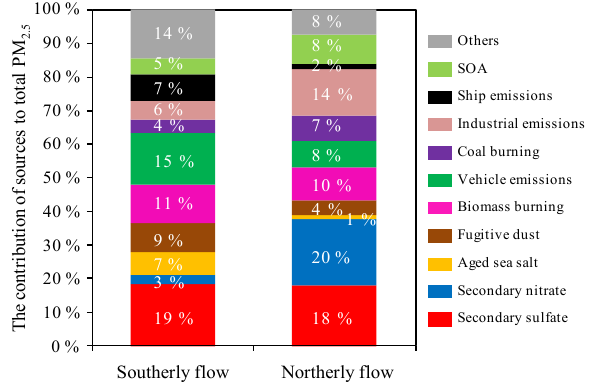
Figure 7. The contributions of PM 2 . 5 sources under southerly flow and northerly flow conditions in the